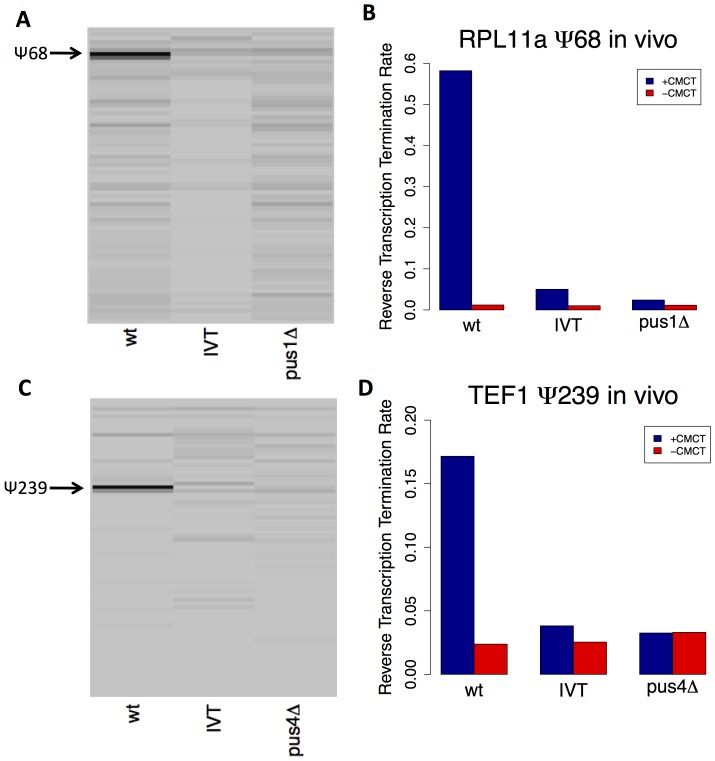
Primer Extension Analysis of Pseudouridine Sites in RPL11a and TEF1 mRNAs.Reverse transcription using fluorescent gene-specific primers for RPL11a (A–B) or TEF1 (C–D) was performed on RNA samples following treatment with CMCT (+CMCT) or mock reactions (-CMCT), and analyzed by capillary electrophoresis. At each position, the difference in primer termination rates between +CMCT and –CMCT conditions was computed from electropherogram intensities and is displayed in a gel-like format. Positions appearing with darker intensities correspond to sites with specific termination induced by CMCT treatment, as expected for pseudouridines. RNA samples examined were natural RNA isolated from wild-type yeast (wt), in vitro transcribed RNA as an unmodified control (IVT), or natural RNA isolated from a mutant yeast strain (pus1Δ or pus4Δ). The site of pseudouridylation is marked by an arrow. Quantification of the site-specific termination rate for each RNA sample is plotted for RPL11a psi-68 (B) and TEF1 psi-239 (D).